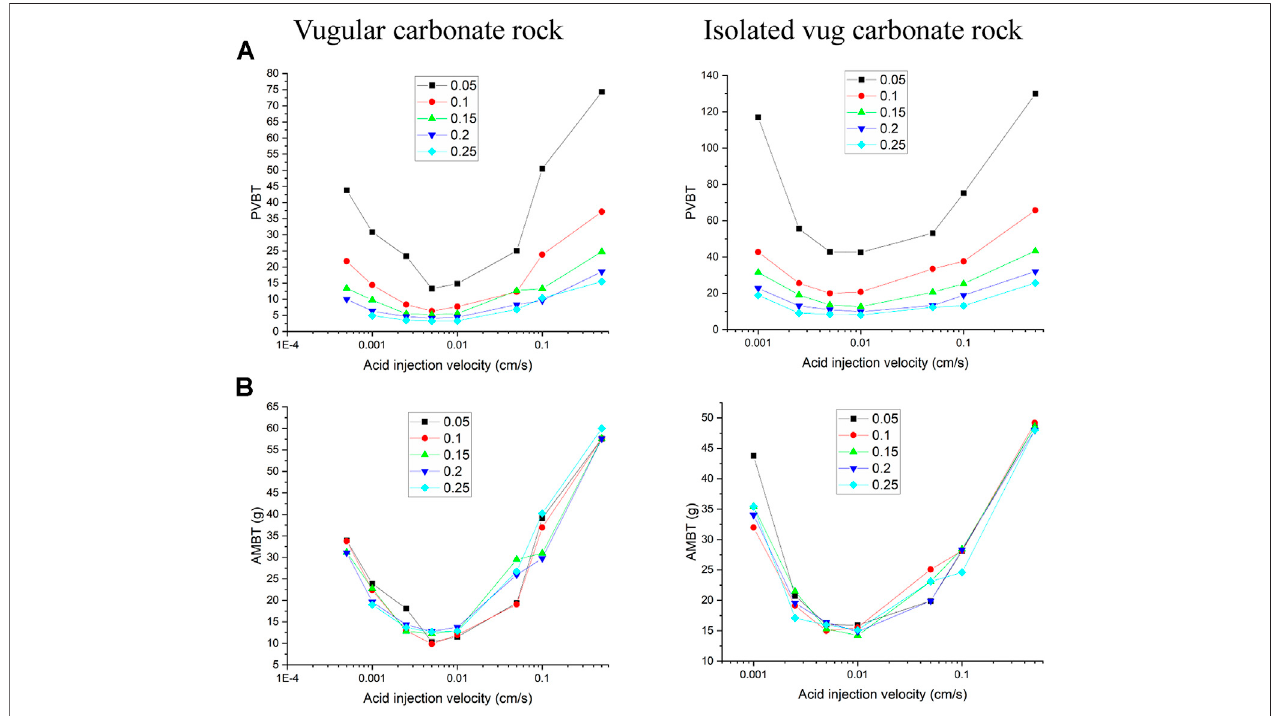
FIGURE 7 | Effect of acid injection concentration on the acidizing results: (A) pore volume to breakthrough (PVBT) and (B) acid mass to breakthrough (AMBT).